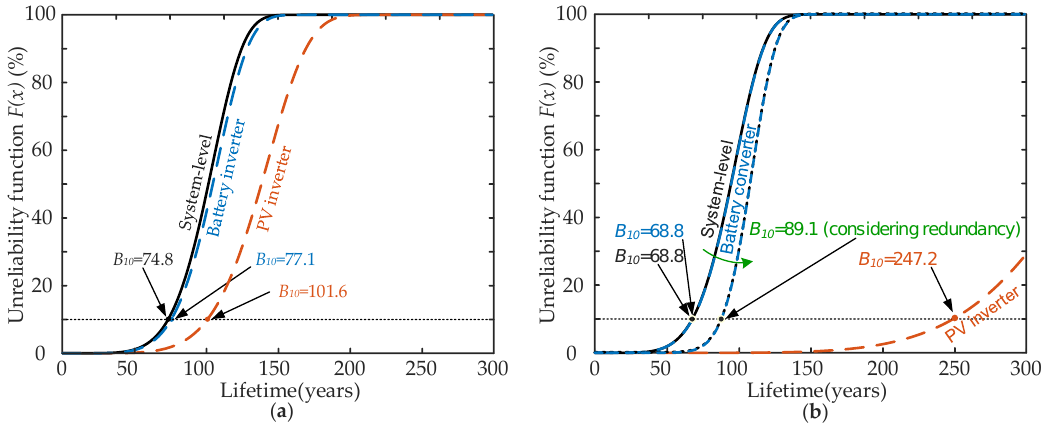
Figure 13. Unreliability function of the DC- and AC-coupled PV-battery system: ( a ) AC-coupled configuration and ( b ) DC-coupled